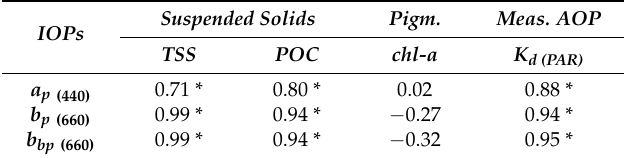
Table 3. Correlation coefficients between IOPs and suspended solids, chl-a and AOPs. Data are from high water only ( n = 27). * indicates significant correlation at p < 0.05. Suspended Solids Pigm. Meas. AOP IOPs